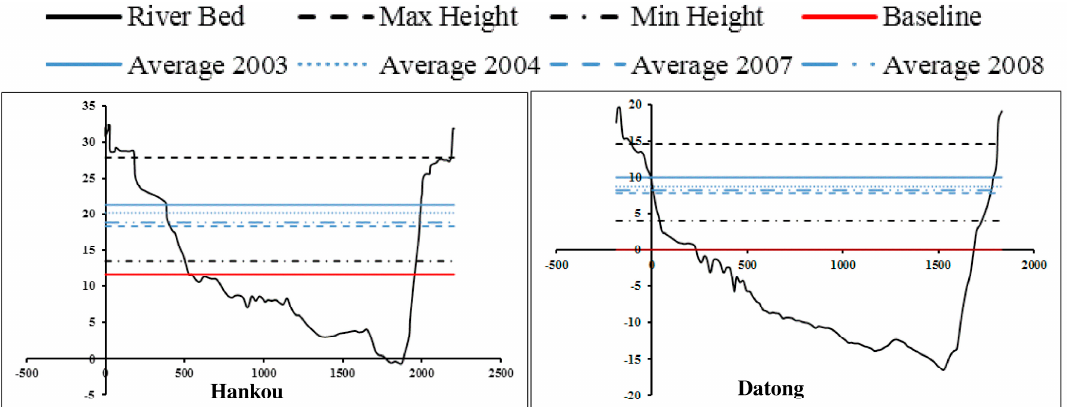
Figure 7. River cross-sections illustrating the riverbed, maximum and minimum water height for the study period 2003–2008, and average water height for 2003, 2004, 2007, and 2008. The area of the triangle has a constant value whereas the area of the trapezium changes with height. In order to obtain the time series height, the areas were divided by the average river width. The procedure used to obtain the time series river width was adopted because the riverbed is irregular.